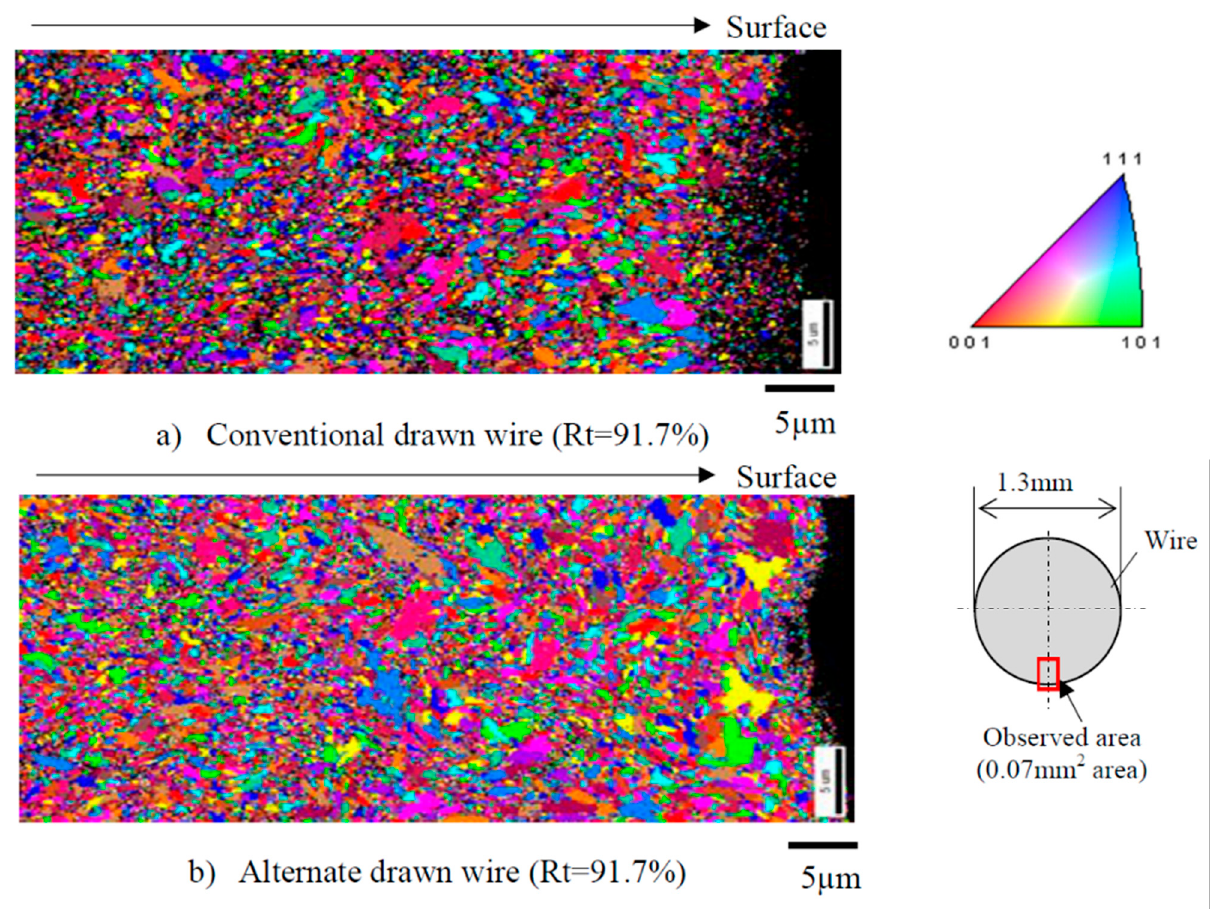
Figure 30. Grain sizes of drawn wire (Rt = 9 1.7%): ( a ) conventional drawing and ( b ) novel alternative wire drawing. Reprinted with permission from ref. [70].